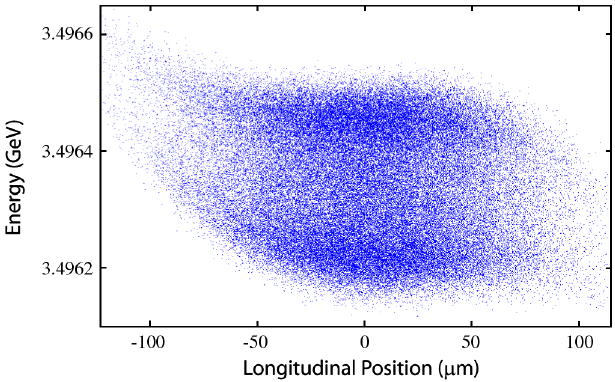
FIG. 4. Particle phase space for ELEGANT simulation of pa- rameters in Table I. The two horizontal stripes of higher density are signatures of a sinusoidal modulation. A third-harmonic accelerating cavity produces the flat central portion of the beam.